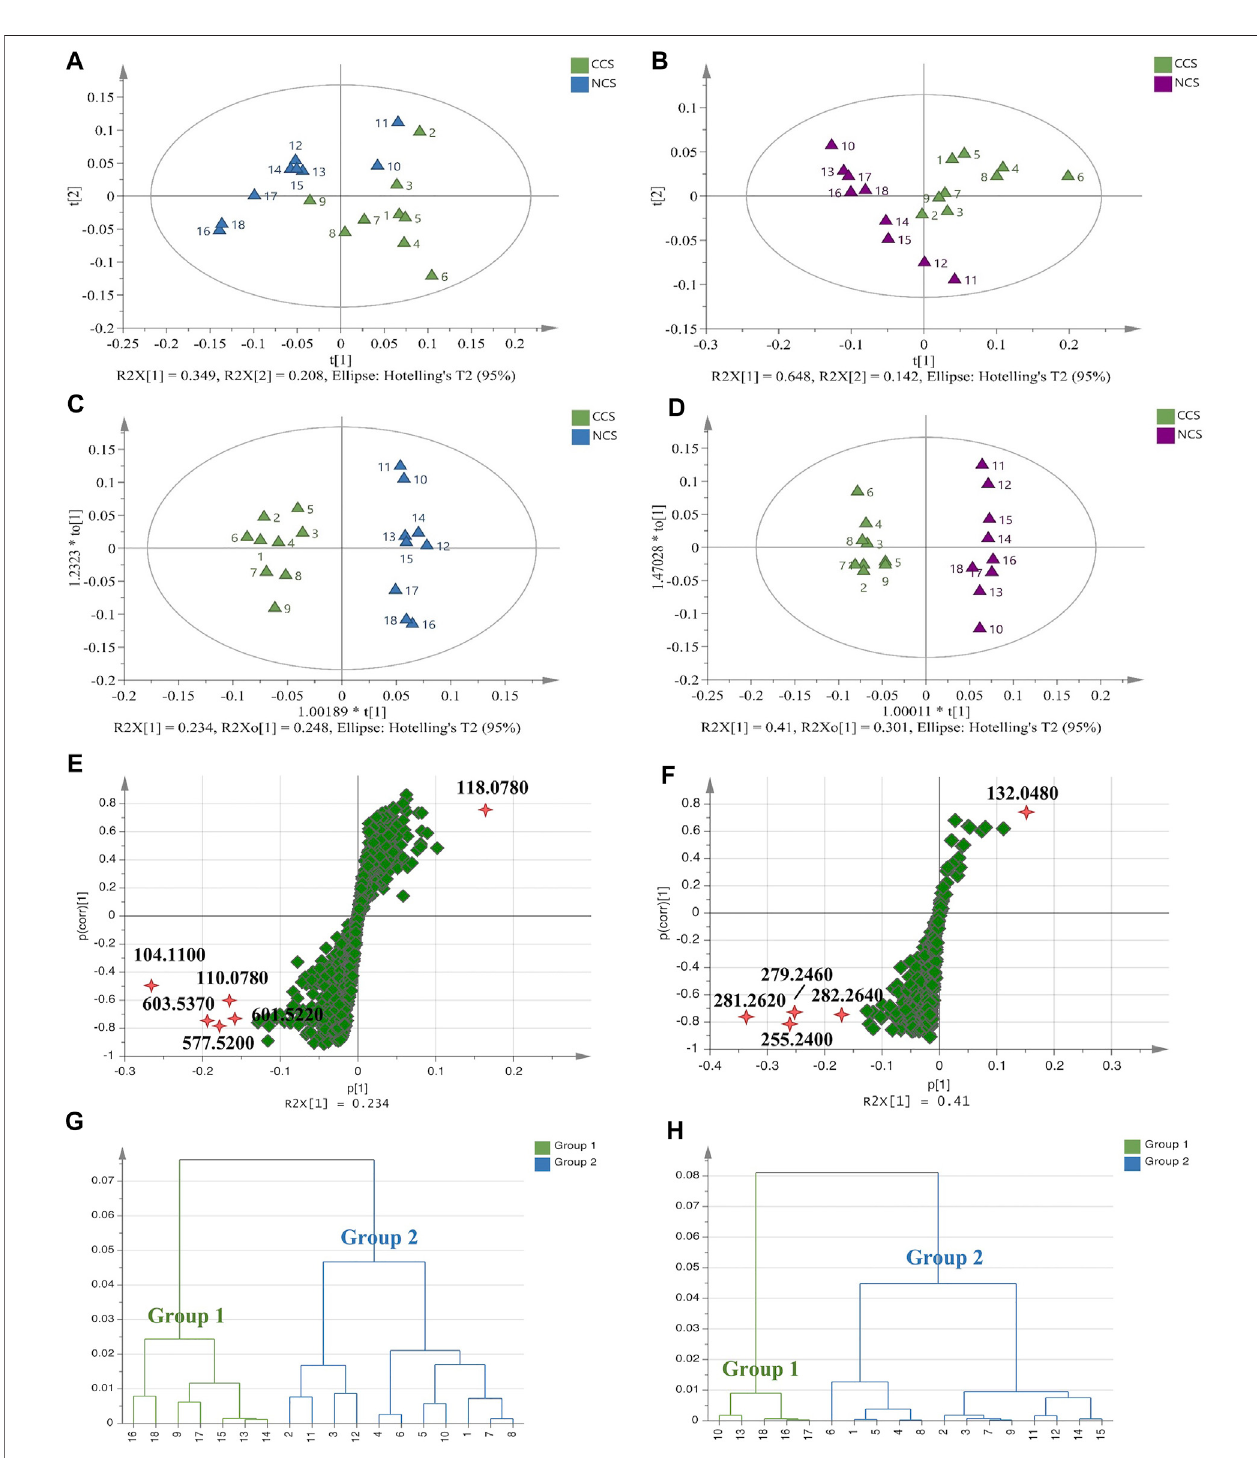
FIGURE 5 | Multivariate statistical analysis of TOF-SIMS data of all CCS and NCS samples. (A,B) : PCA score plots. (C,D) : OPLS-DA score plots. (E,F) : S-plot diagrams. (G,H) : HCA dendrograms. (A,C,E,G) : Data in positive mode. (B,D,F,H) : Data in negative mode.